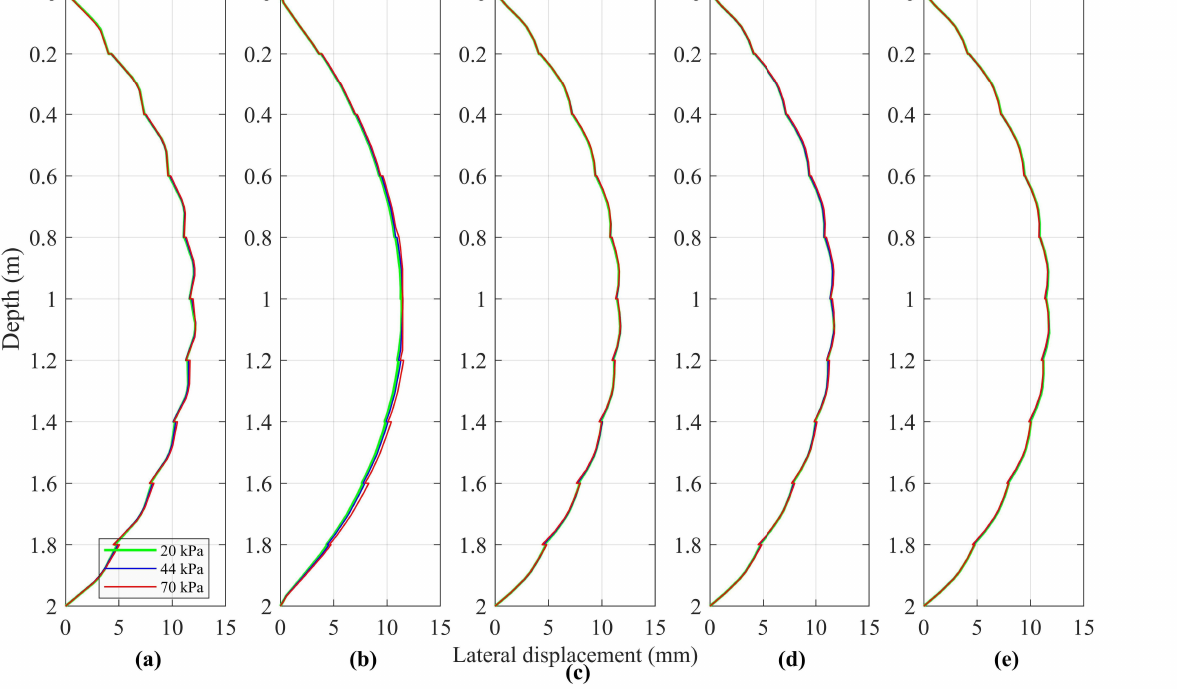
Figure 6. Effect of compaction load q and compaction procedures on open face lateral displacement of SGC mass: for case of p = 1000 kPa, q = 20, 44 and 70 kPa: ( a ) Type-I; ( b ) Type-II; ( c ) Type-III ( w = 0.7 m); ( d ) Type-III ( w = 0.35 m); ( e ) Type-III ( w = 0.175